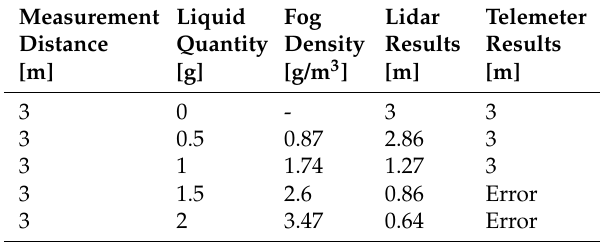
Table 3. The results for LIDAR and Telemeter in different fog